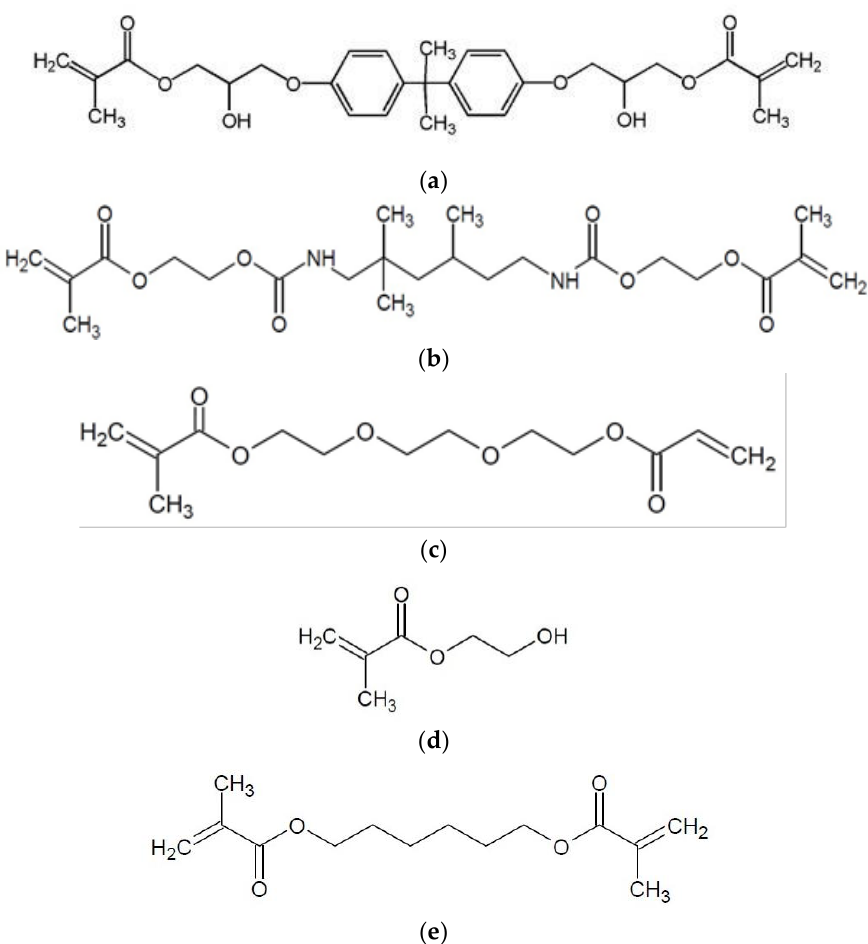
Figure 1. Chemical structures of bisphenol A-glycidyl methacrylate (bis-GMA, ( a )), urethane dimethacrylate (UDMA, ( b )), triethylene glycol dimethacrylate (TEGDMA, ( c )), 2-hydroxyethyl methacrylate (HEMA, ( d )) and 1,6-hexanediol dimethacrylate (HDDMA, ( e )) monomers.